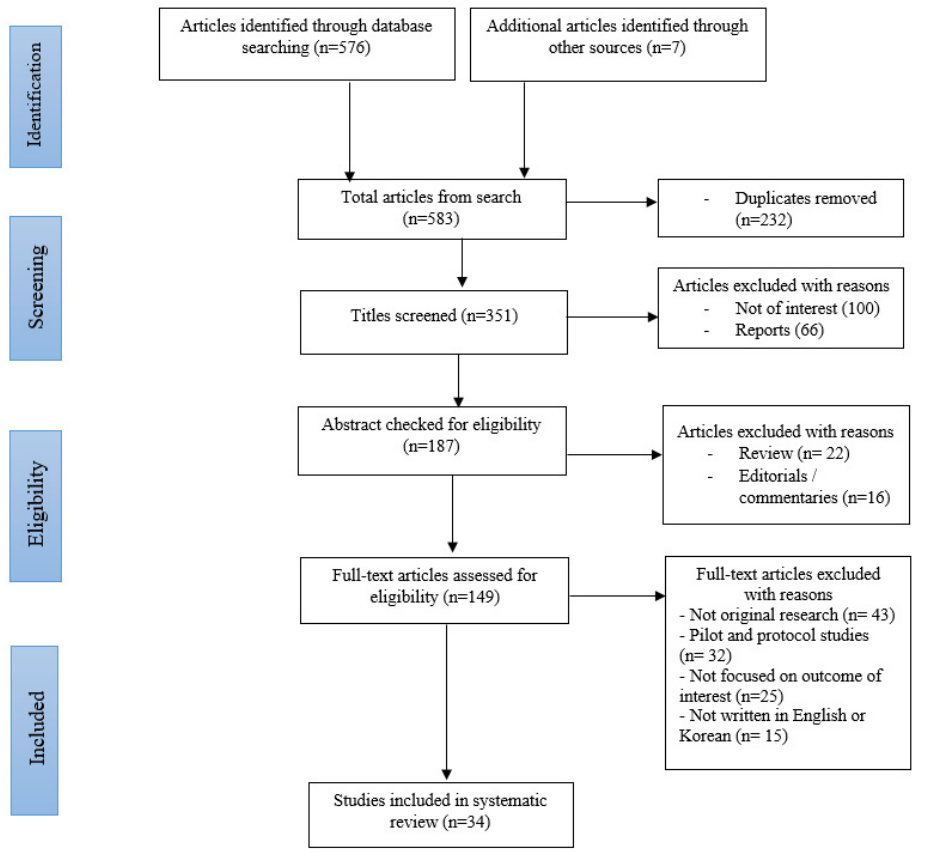
Figure 1. PRISMA Flow diagram showing the selection of review articles.